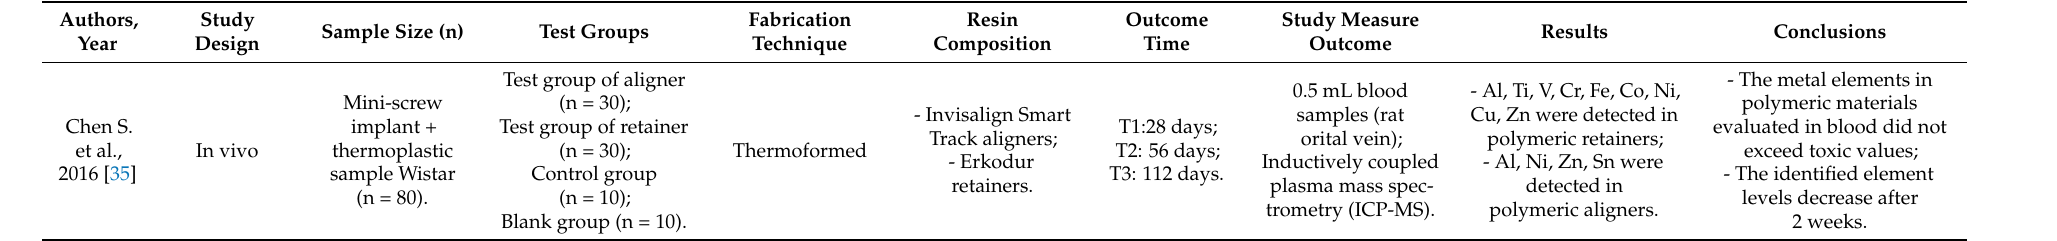
Table 2. Summary of parameters and results from in vivo included studies.